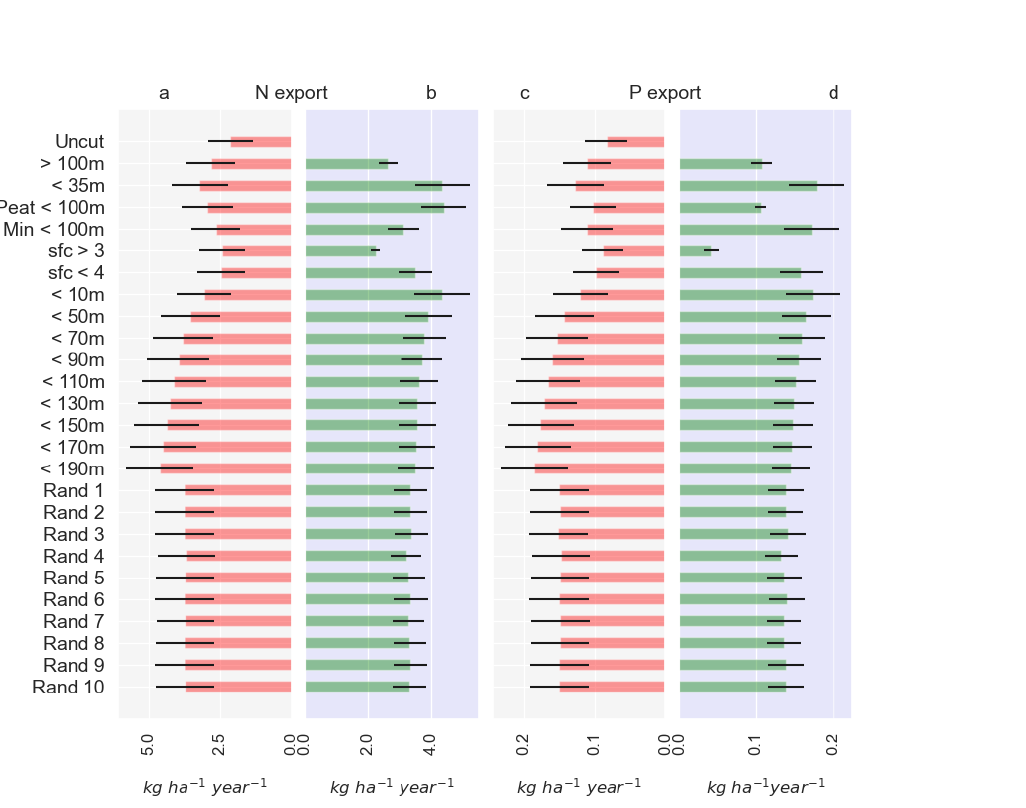
Figure 6. Mean annual nitrogen (N) and phosphorus (P) export loads (in kg ha − 1 year − 1 ) over 10-year period after clear-cut in Catchment 2. Panels ( a ) and ( c ) show the total export load per catchment area. The panels ( b ) and ( d ) show the specific export loads (the increase of export load compared to uncut case, normalized by the harvested area). The black lines represent the standard deviation of annual export load. The clear-cut scenarios are summarized in Table